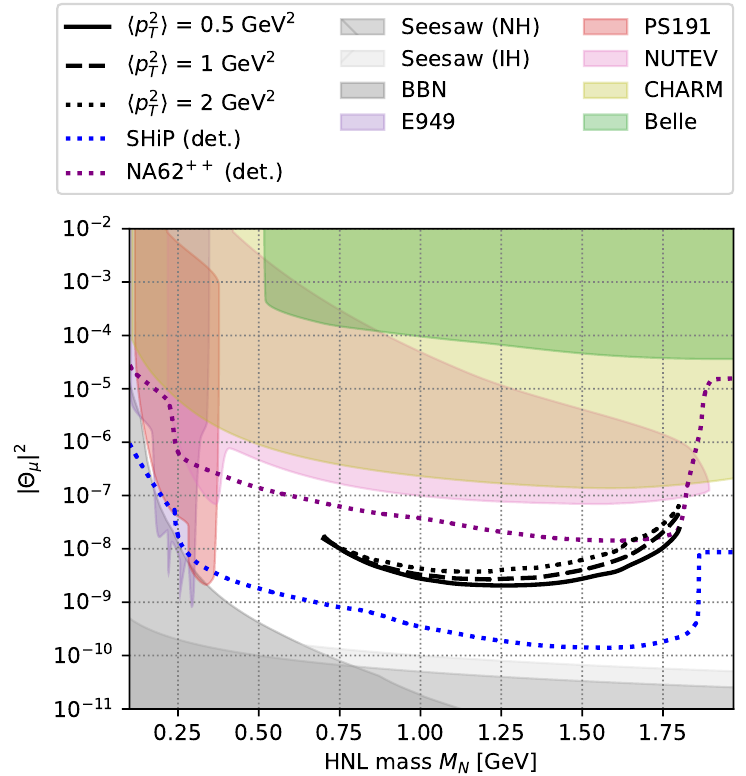
Figure 12. E(cid:11)ect of varying the width of the heavy meson p lepton number violation (90% CL), for an HNL coupling to the muon. Black lines represent the model-selection sensitivity of SHiP for various values of (cid:10) (cid:11) best-(cid:12)t value = 1 GeV 2 from the LEBC-EHS collaboration p 2 T